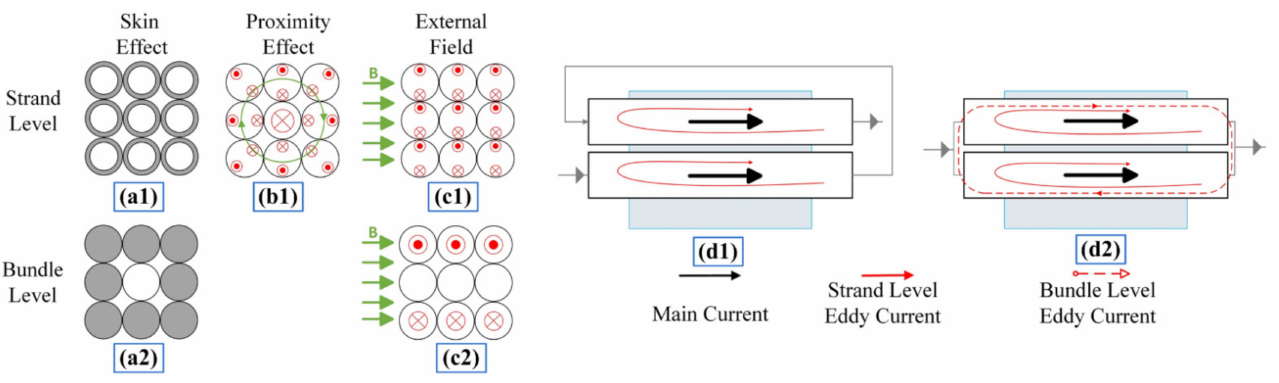
Figure 1. Different types of eddy current losses at the strand level and bundle level: ( a1 , a2 ) skin effect losses; ( b1 , b2 ) proximity effect losses; ( c1 , c2 ) eddy current losses due to the external field; ( d1 , d2 ) circulating currents losses in series- and parallel-connected